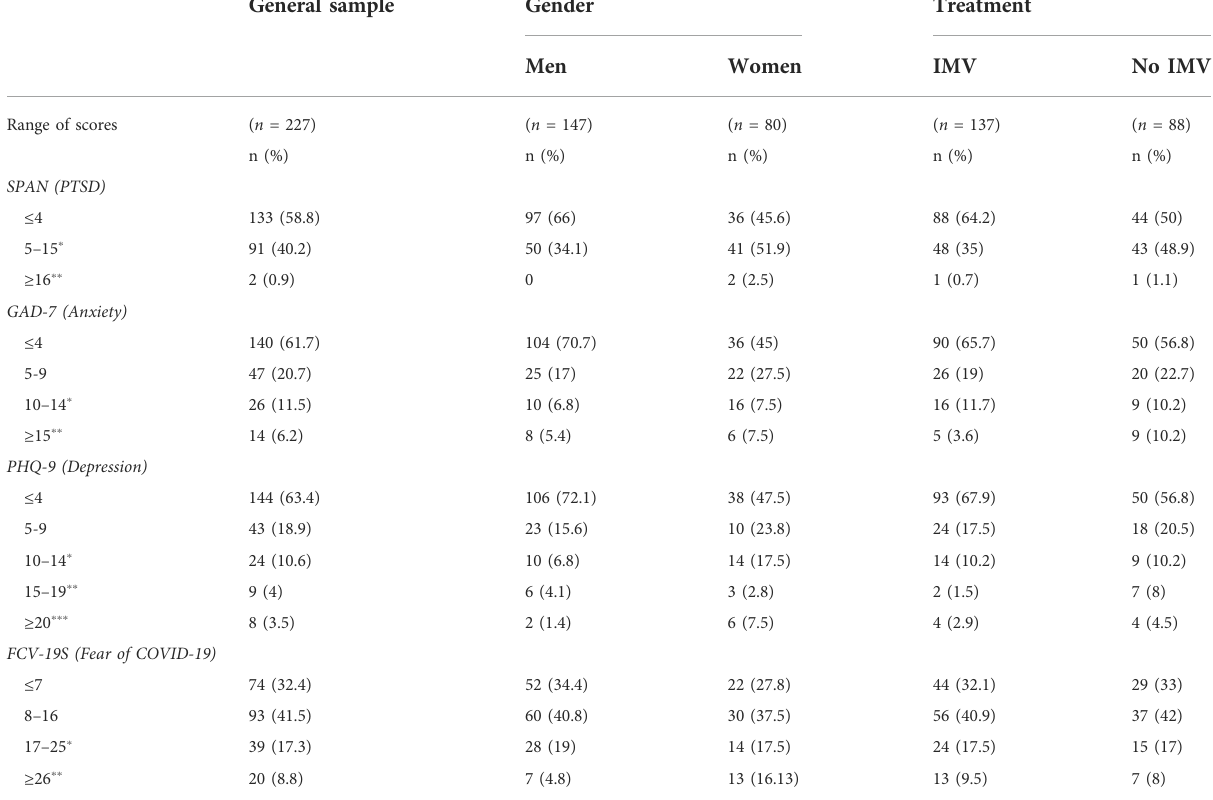
Note: p scoresassociatedwithamoderatedegreeofsymptomatology, pp scoresassociatedwithaseveredegreeofsymptomatology,and ppp scoresassociatedwithamoderate – severedegreeof symptomatology.